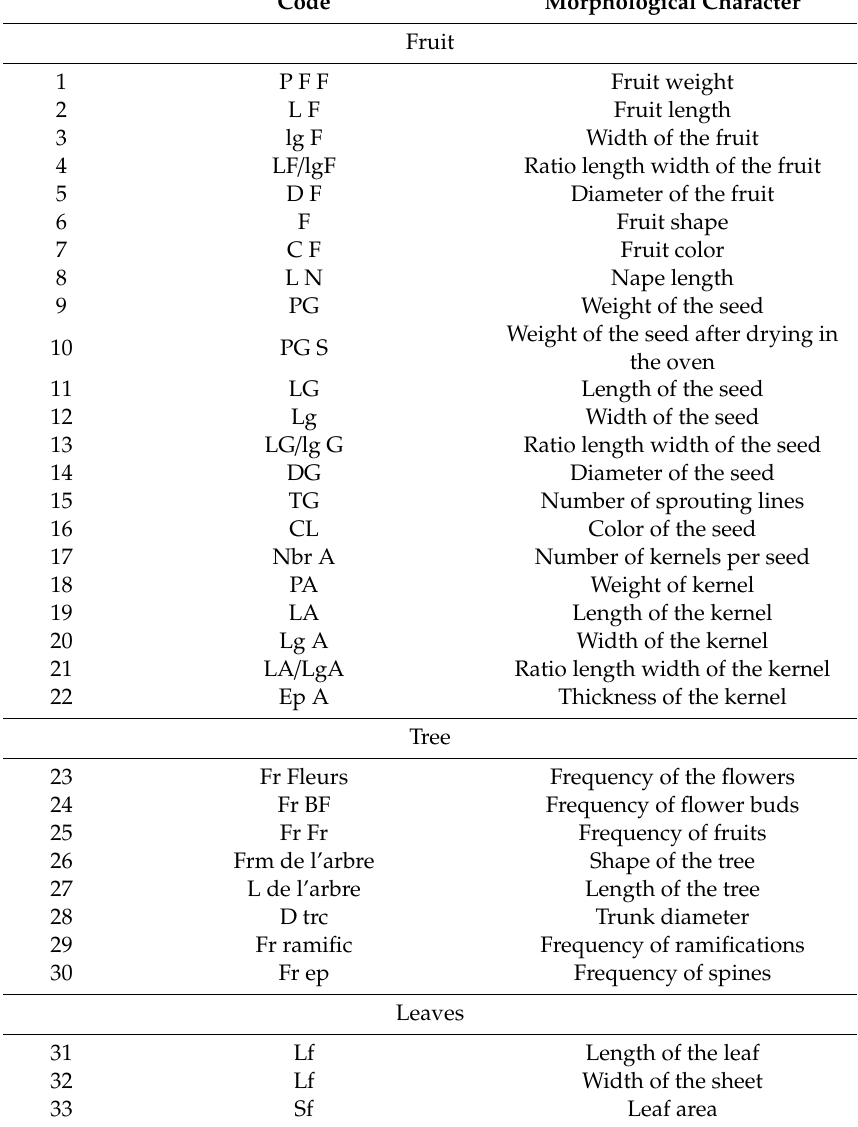
Table 8. Quantitative and qualitative morphological characters of argan trees.